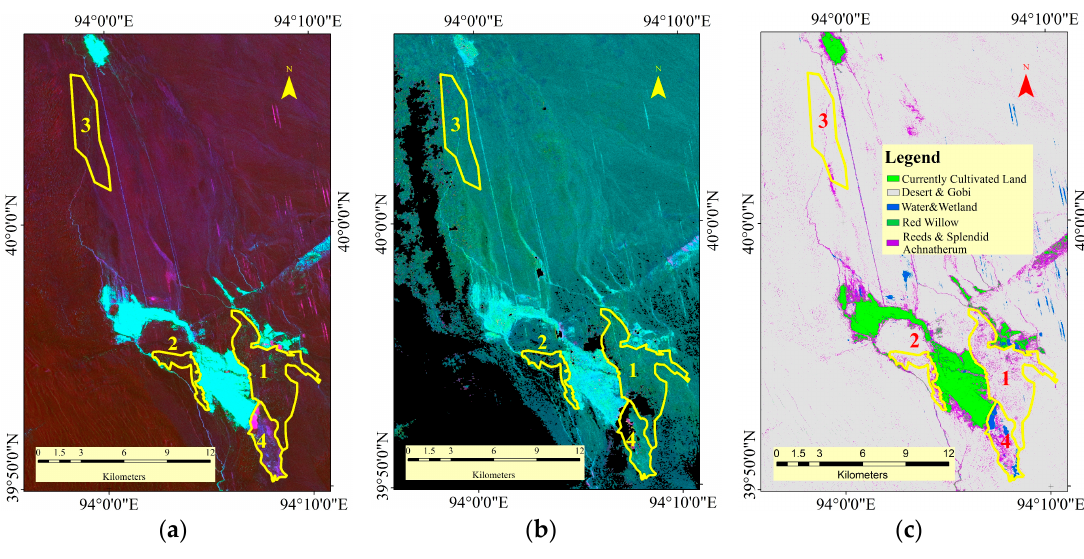
Figure 11. Feature extraction using multi-temporal PALSAR-1 images. ( a ) Intensity feature composite images; ( b ) D-InSAR interferogram with a CC value greater than 0.25; ( c ) classification results.